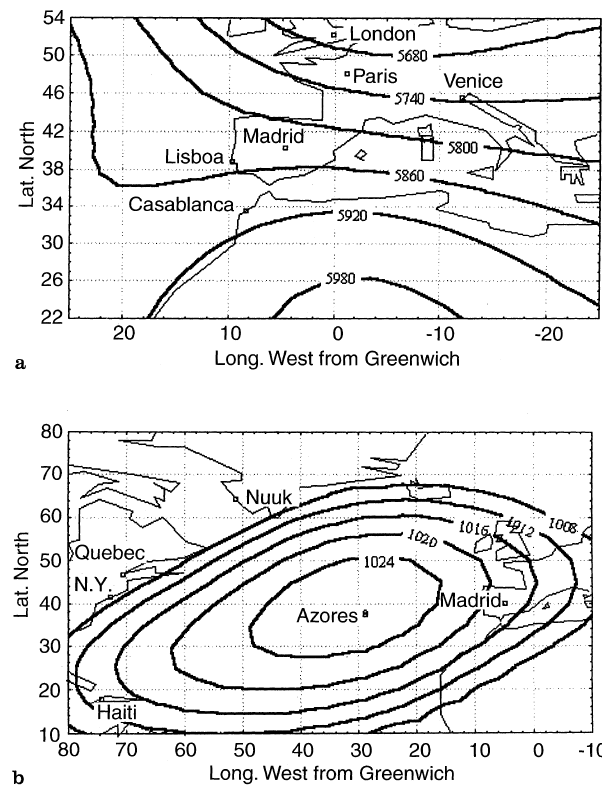
Fig. 3. a Upper: geopotential pattern over the western Mediterranean in July 1966. b Lower: sea-level pressure pattern over the North Atlantic area in July 1966